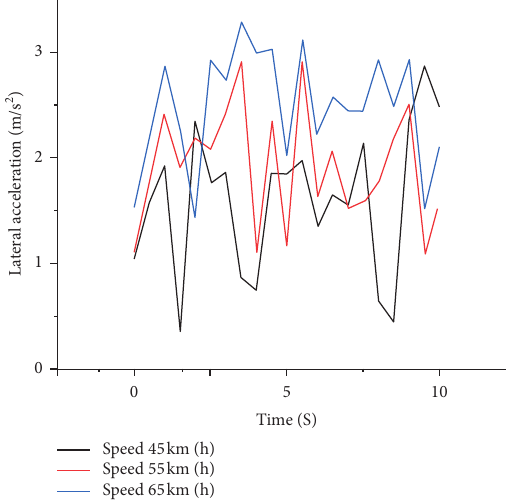
Figure 11: Lateral acceleration change of the uniform motion lane changing